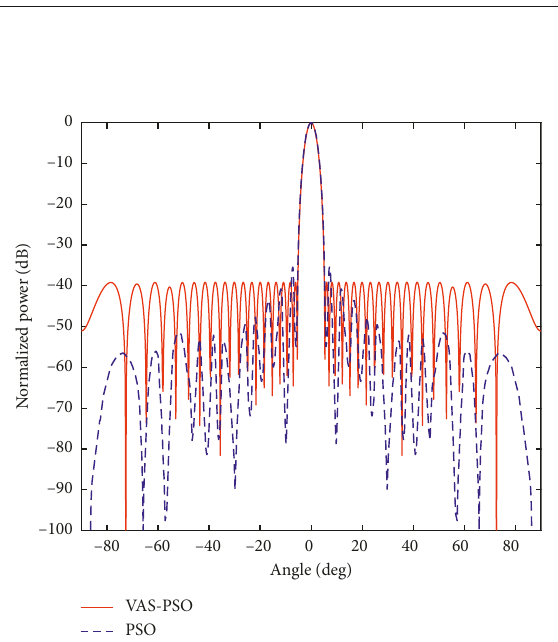
Figure 10: PSLL comparison between PSO-CVX and the graph of the optimized excitation amplitude in [16].